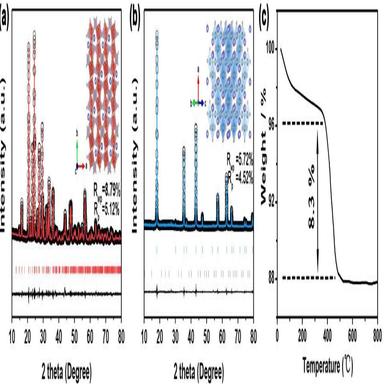
SEM images of (a) LVP/C and (b) LTO; HRTEM images of (c) LVP/C and (d) LTO.